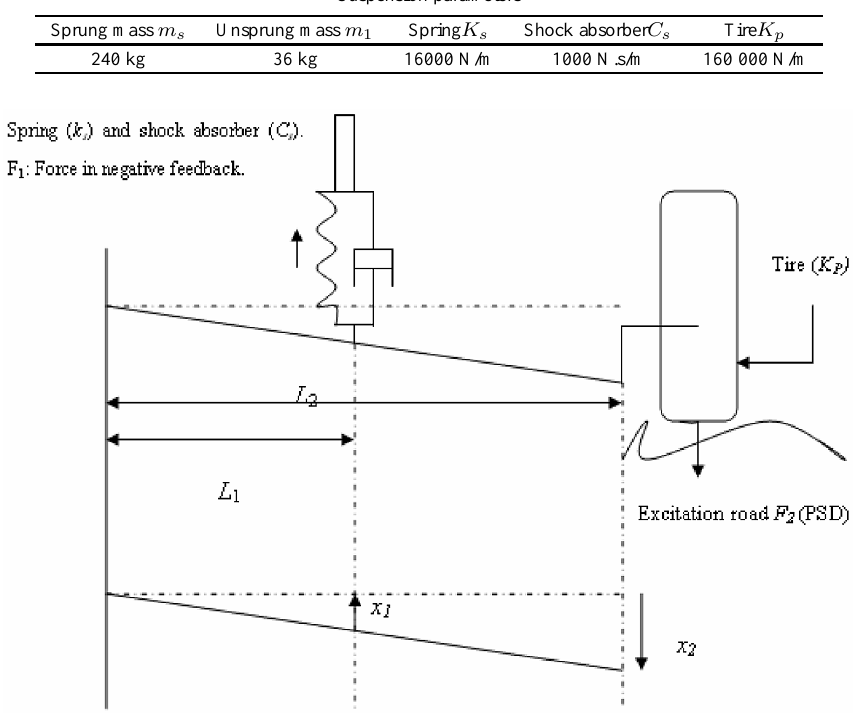
Fig. 2. Control of the lower suspension arm of a